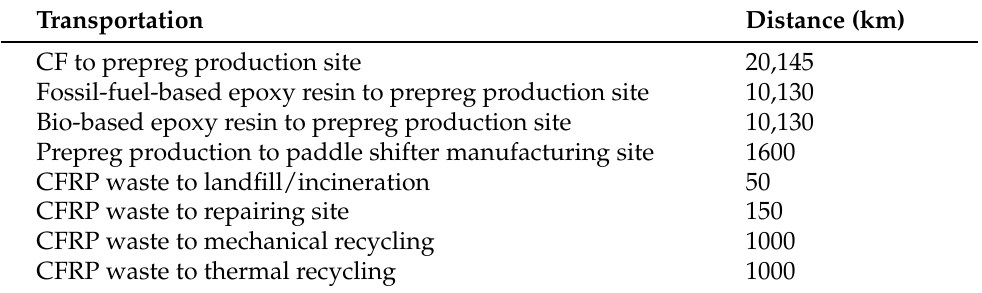
Table 9. Inventory data of